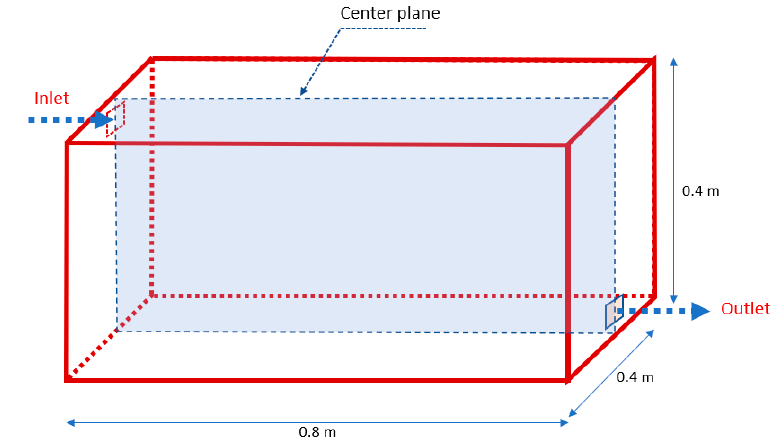
Figure 1. Geometric parameters of the first physical experiment.